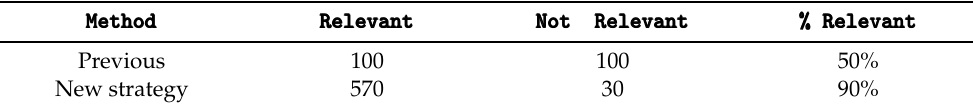
Table 5. Comparison of both prioritization methods based on average monthly data.